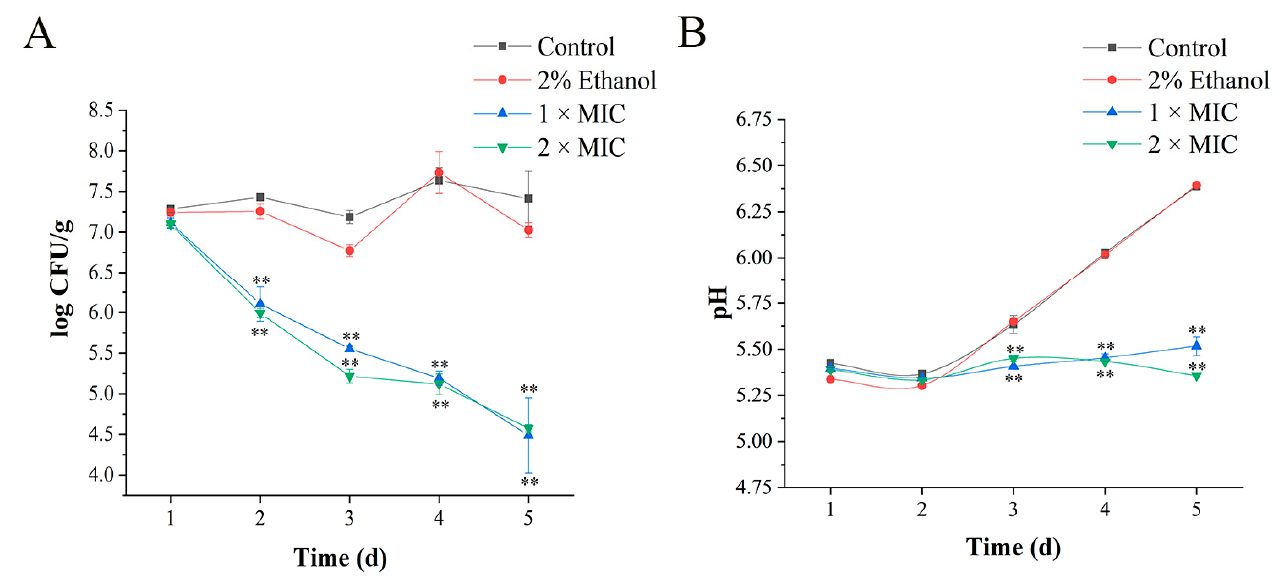
Figure 10. Log CFU/g of P. lundensis inoculated in pork samples stored at 4 °C ( A ). Changes in pH value of pork samples ( B ). The asterisks indicate statistically significant differences compared with the control (** p < 0.01).